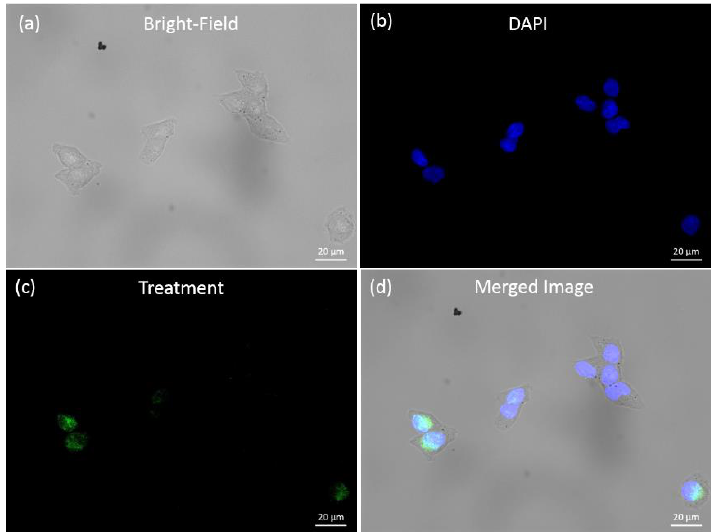
Figure 4. Images of A2780cis cells: ( a ) Bright-field image (63x iris oil immersion objective). ( b ) Fluorescence images after staining with DAPI (G 365 excitation filter). ( c ) Fluorescence images after staining with 13 (excitation filter BP 470/40): ( d ) merged fluorescence images ( b ) and ( c ).